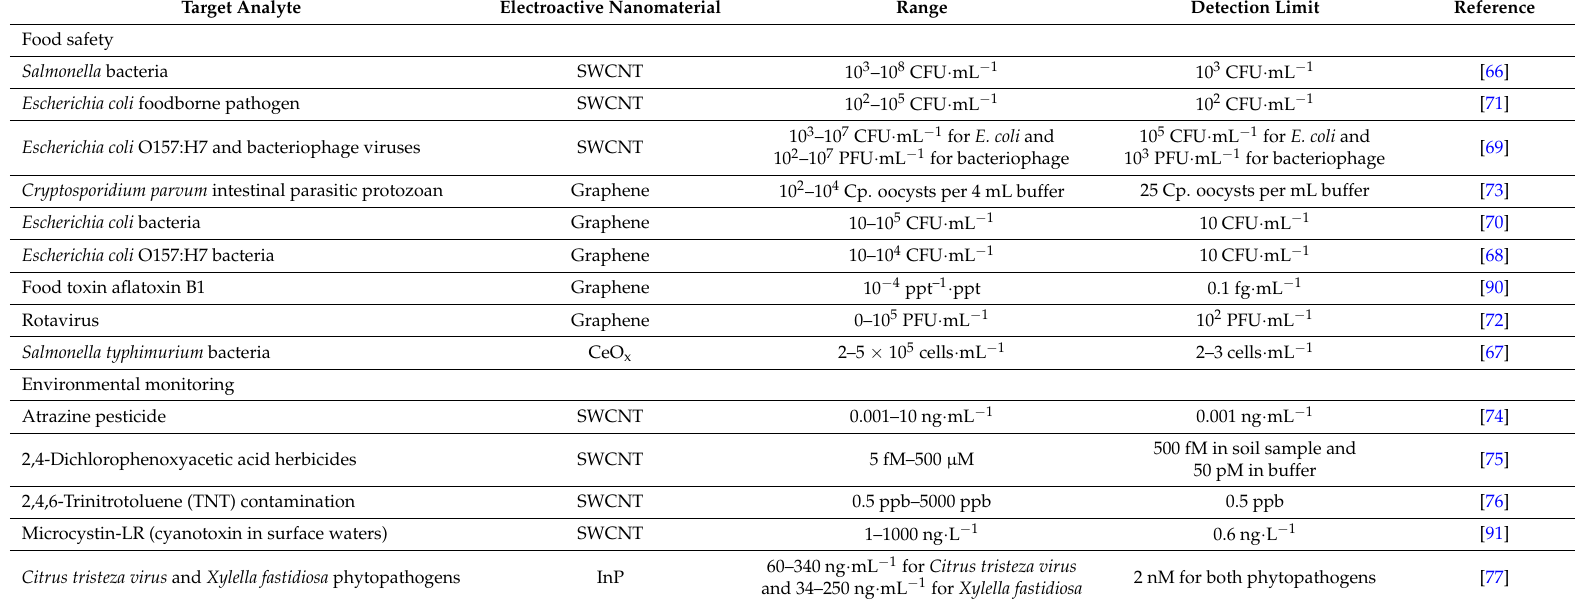
Table 2. Recent reports on immunoFET sensors based on various types of nanomaterials listed along with their application in food safety and environmental monitoring